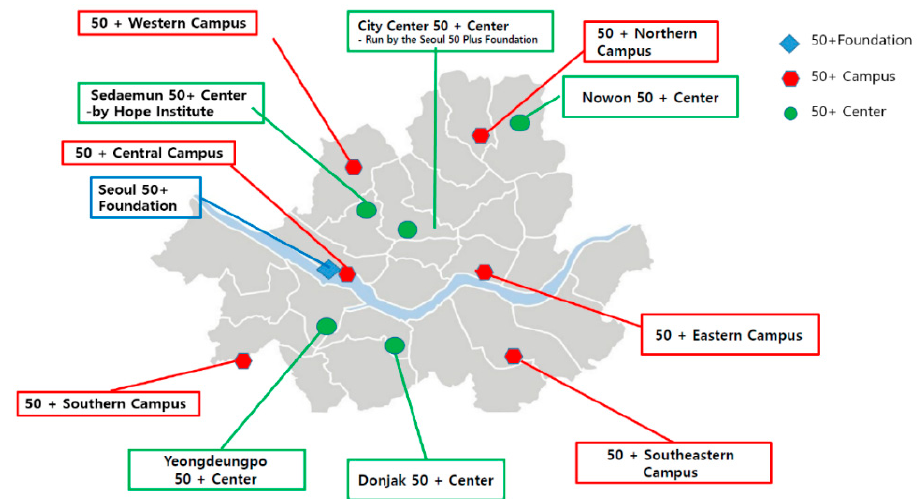
Figure 1. Seoul 50 Plus Foundation (as of 2018).